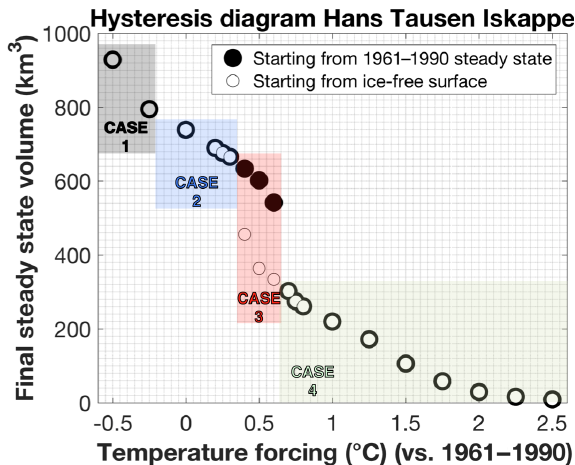
Figure 10. Final steady-state volumes under different climatic con- ditions and for different starting geometries. The four cases are the same as in Fig. 9 and are described in the text. Bold circle outlines mean that the final steady state is independent from the initial con-